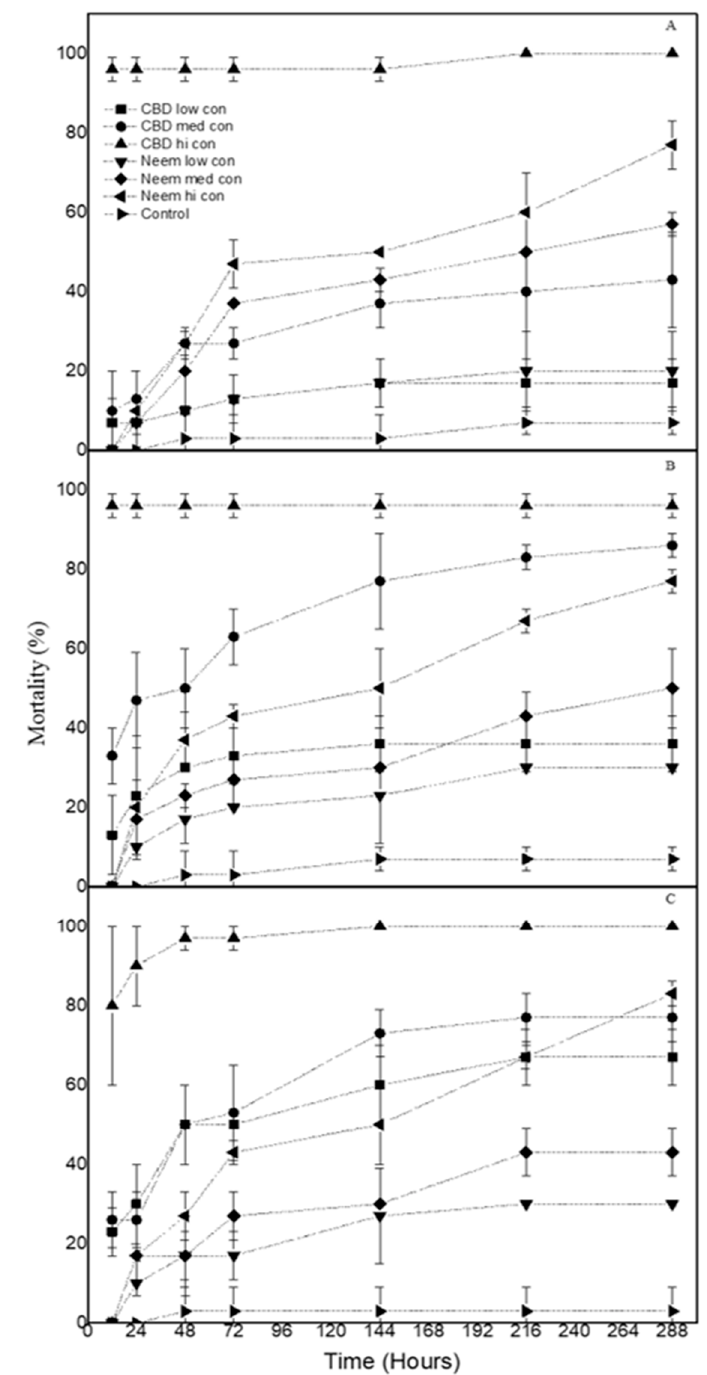
Figure 2. Mean Mortality (% ± sd) of O. surinamensis larvae treated with CBD oil and neem oil at three concentrations on ( A ) wheat ( B ) corn and ( C ) rice. (low con: 15 mg/mL, med con: 45 mg/mL, hi con: 90 mg/mL).